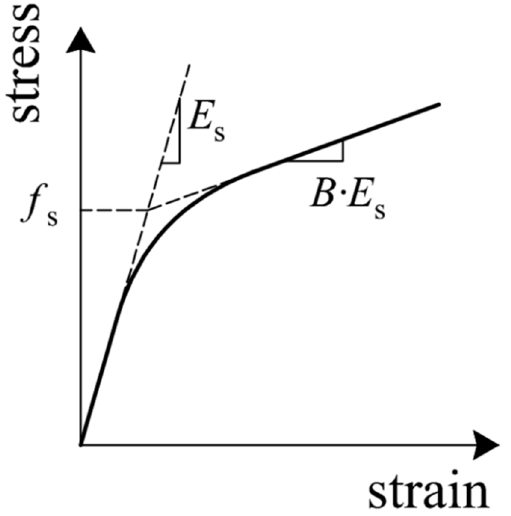
Figure 5. Stress-strain behavior of steel.